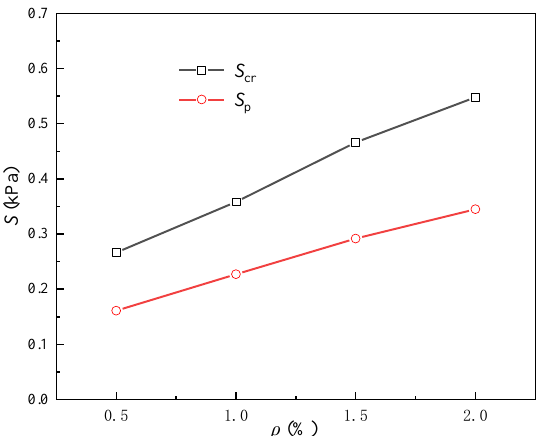
Figure 14. Influence of fiber volume fraction on the energy absorption capacity. which include water/cement contents, fiber type and content, aggregate source, additive type, specimen type, loading method and so on. Therefore, although the aforementioned two sets of tests are both for steel fiber concrete specimens, there are great differences both in results and theoretical analysis show that, in the same group of tests, when only the content of steel fiber is changed, the macroscopic constitutive behavior and mesoscopic damage evolution process of fiber concrete show good regularity with the change of fiber